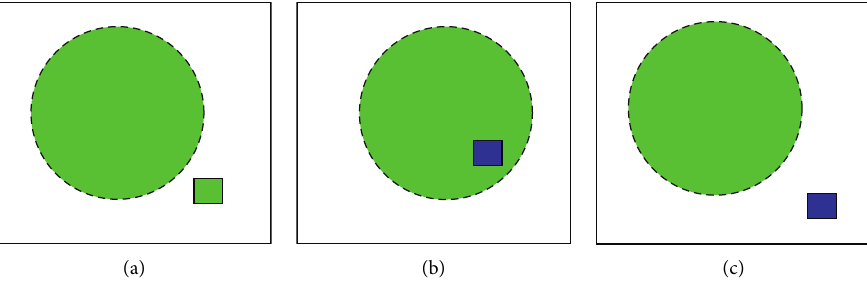
Figure 4: Three different scenarios: (a) incoming instance’s label is the same as the nearest microcluster’s label; (b) incoming instance’s label varies from the nearest microcluster’s label, which represents noisy instance; and (c) incoming instance as a new concept does not drop into the nearest microcluster and its label is different from the nearest microcluster’s label. Note: the color represents the class label, the rectangle suggests the incoming instance, and the circle represents the nearest